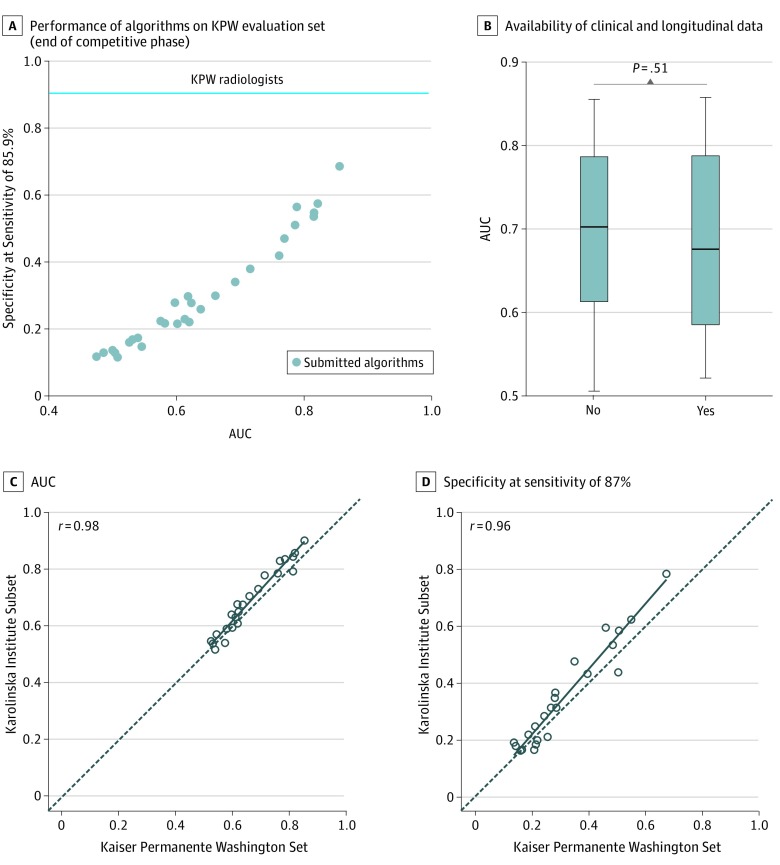
Performance of the Algorithms Submitted at the End of the Competitive PhaseIndividual algorithm performance submitted at the end of the competitive phase on Kaiser Permamente Washington (KPW) and Karolinska Institute data. A, Area under the curve (AUC) and specificity computed at KPW radiologists' sensitivity of 85.9% of 31 methods submitted to the Digital Mammography Digital Mammography Dialogue on Reverse Engineering Assessment and Methods Challenge and evaluated on KPW evaluation set. B, The performance of methods is not significantly higher when clinical, demographic, and longitudinal data are provided. C-D, The AUC and specificity computed at Breast Cancer Surveillance Consortium’s sensitivity of 86.9% of methods evaluated on the KPW evaluation set generalize to the Karolinska Institute data.